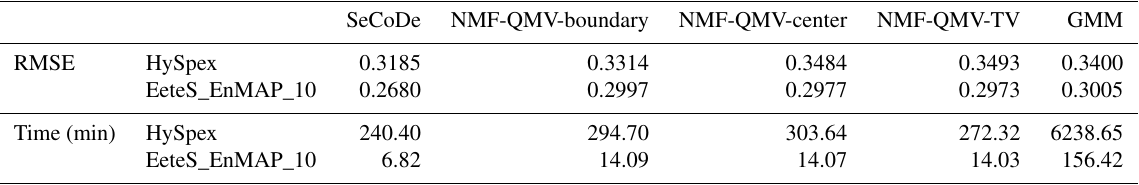
Table 6. Quantitative assessment of unmixing algorithms for the sub3 region.